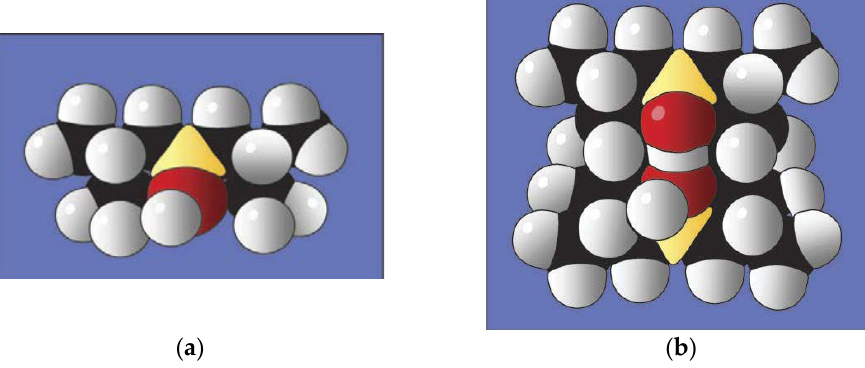
Figure 2. Molecular models of the monomer of diisobutyl silane diol ( a ) and the dimer ( b ) that was proposed as the structural unit of the discotic phase [12].